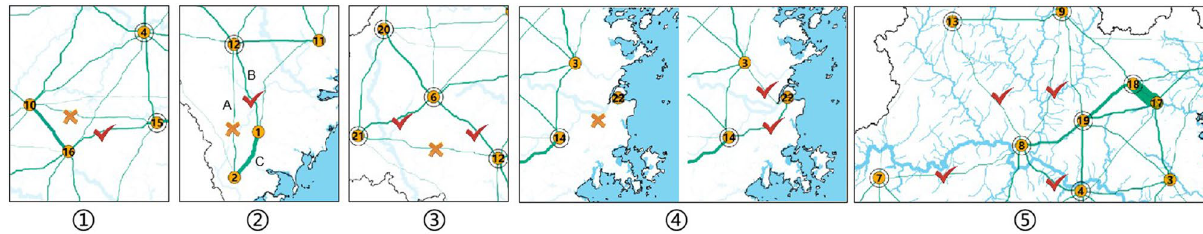
Figure 17. Diagram of principles for ecological network selection.